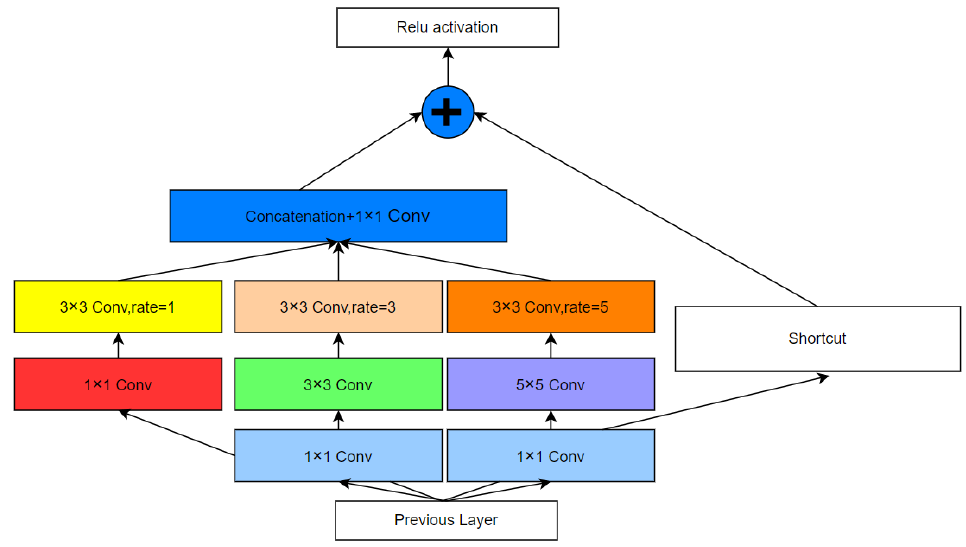
Figure 4. The structure of the RFB.